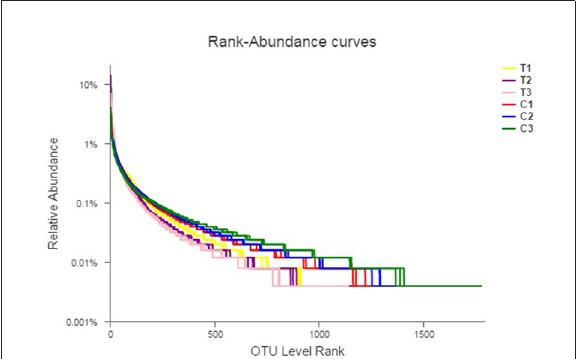
FIGURE1 Rank-abundance curves describing the bacterial abundance and evenness. All data in the experiment represent three independent